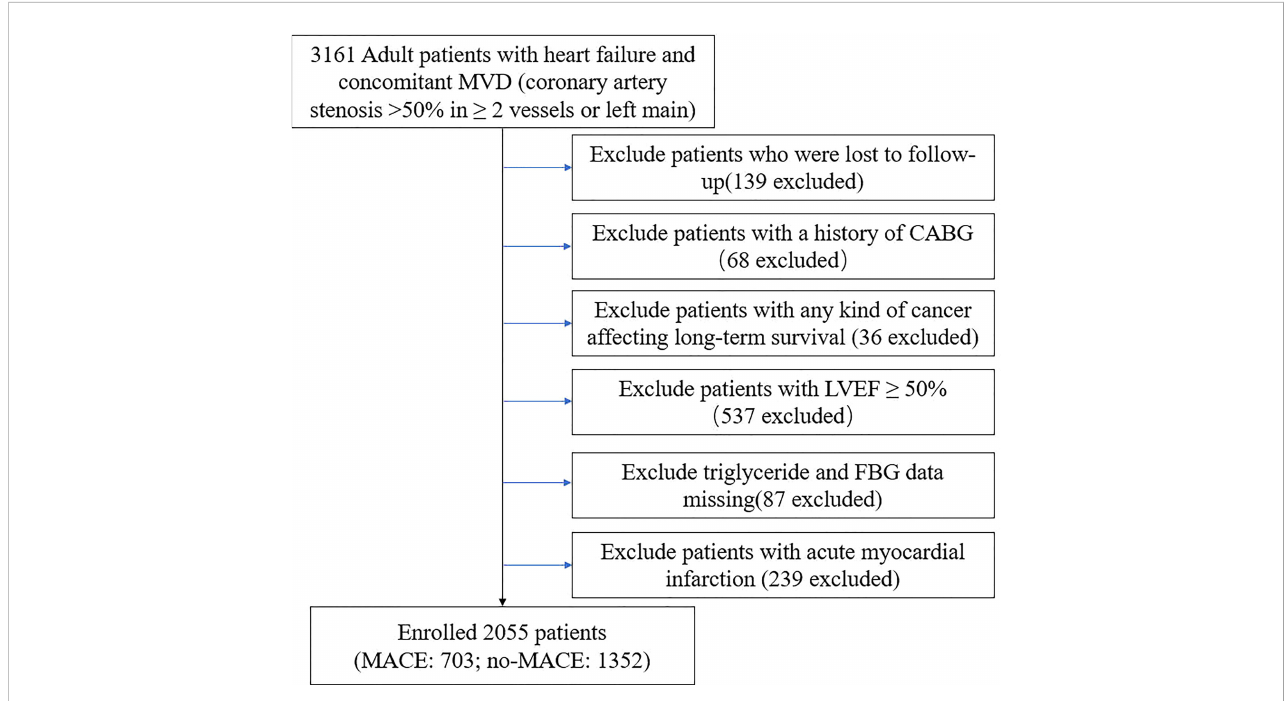
FIGURE 1 Flow chart of study